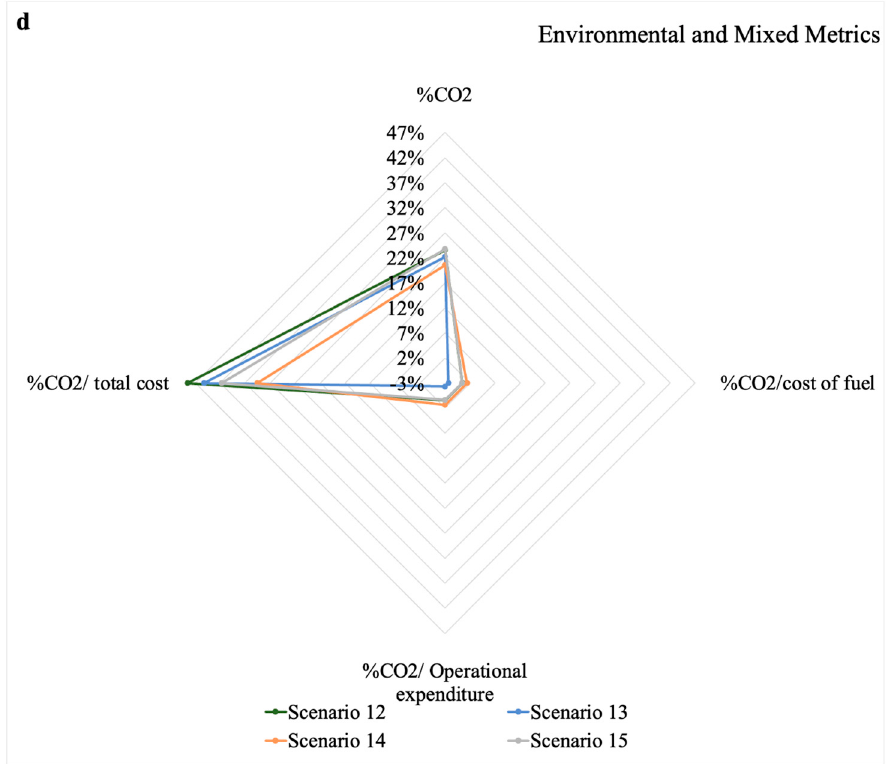
Figure 3. Radar charts for the percentage differences between the scenarios and the reference case, for carbon emissions, carbon emissions per cost of fuel, carbon emissions per operational expenditure and carbon emissions per total cost, with ( a ) scenarios using only digital tools (Scenario 1) or only energy efficient approaches (Scenario 16); ( b ) scenarios using digital tools in three out of the four cases and energy efficient equipment in the fourth (Scenarios 2, 3, 4 and 5); ( c ) scenarios equally implementing digital and energy efficient solutions (Scenarios 6, 7, 8, 9, 10 and 11); ( d ) scenarios where energy efficient equipment is the dominant approach (Scenarios 12, 13, 14 and 15).